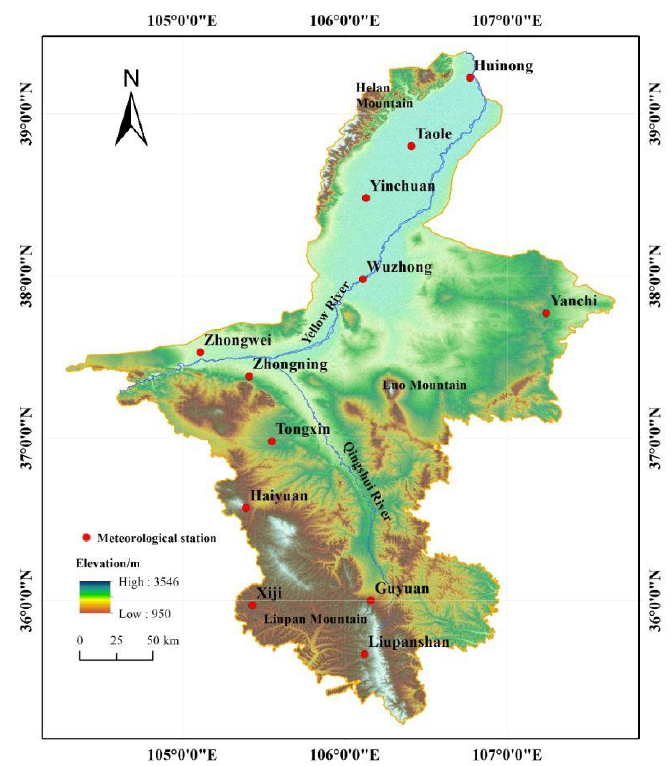
Figure 1. The terrain of Ningxia and the spatial distribution of 12 meteorological stations used in this study. Source: ASTER GDEM 30M (provider: Geospatial Data Cloud website, http://www.gscloud.cn/sources/accessdata/310?pid=302 , accessed on 8 May 2022).